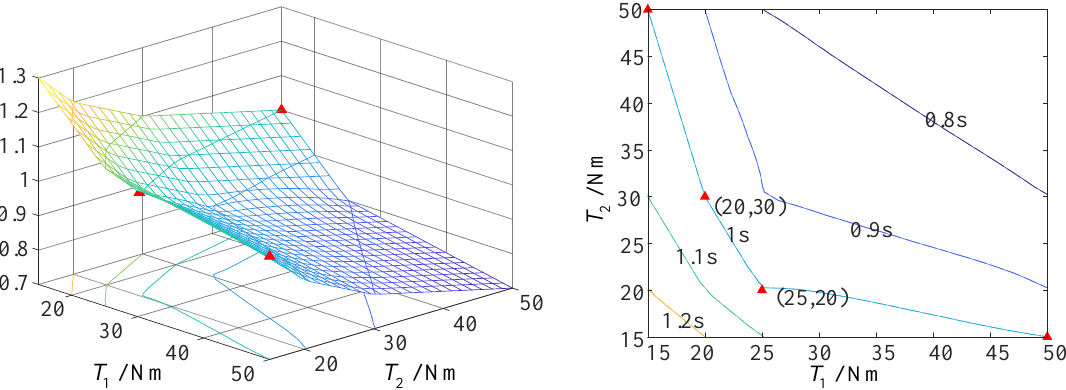
Figure 22. The curve of driving torque and deployment time of folding wing at an airspeed of 20 m/s (fixed-axis – non-fixed-axis stepwise deployment mode). When the fixed-axis – non-fixed-axis stepwise deployment mode is adopted and the airspeed is 30 m/s, the minimum driving torque required by axis 1 to complete the action is 25 Nm, and that required by axis 2 to complete the action is 15 Nm, on the premise that the folding wing can complete the action within 1 s, as shown in Figure 23.